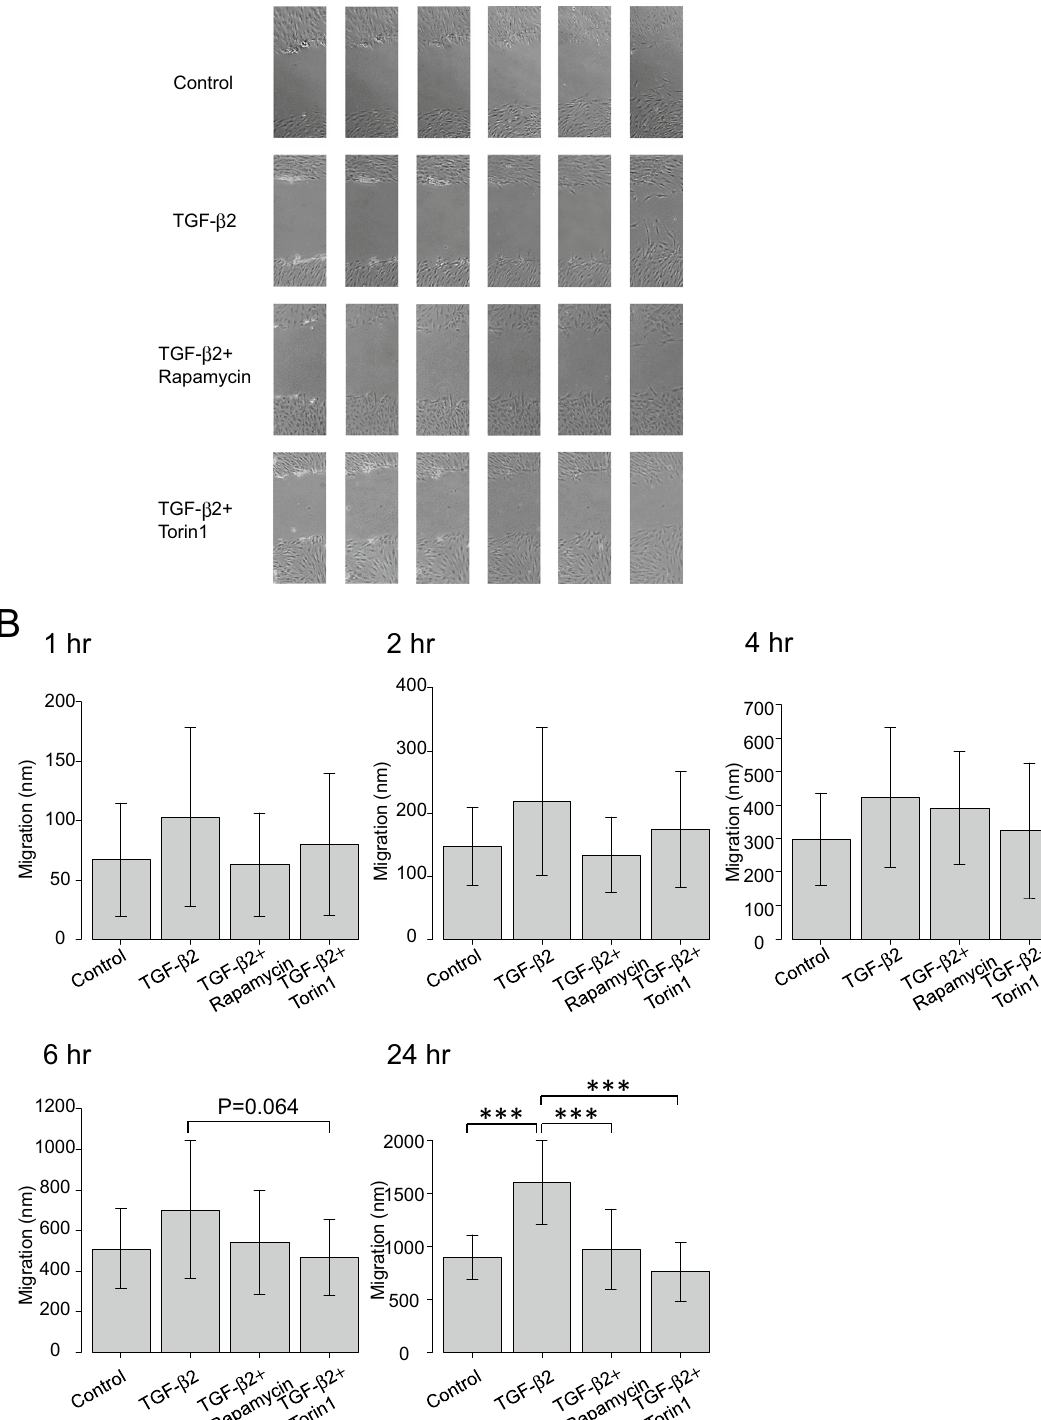
Figure 4. Effect of TGF-β2 and mTOR inhibitors on cell migration. ( A ) Representative phase-contrast images of scratched hTM cells. The shortest distances between the edges of migrated cells (including their protrusions) were measured from both sides. ( B ) Migration of hTMs over 1, 2, 4, 6, and 24 h (n = 15). The baseline indicates the migration distance of cells not exposed to TGF-β2 or the mTOR inhibitors. TGF-β2 significantly accelerated migration to 24 h (P < 0.001); this was suppressed by mTOR inhibitors (P < 0.001). One-way analysis of variance followed by the Tukey post-hoc test. ***P <